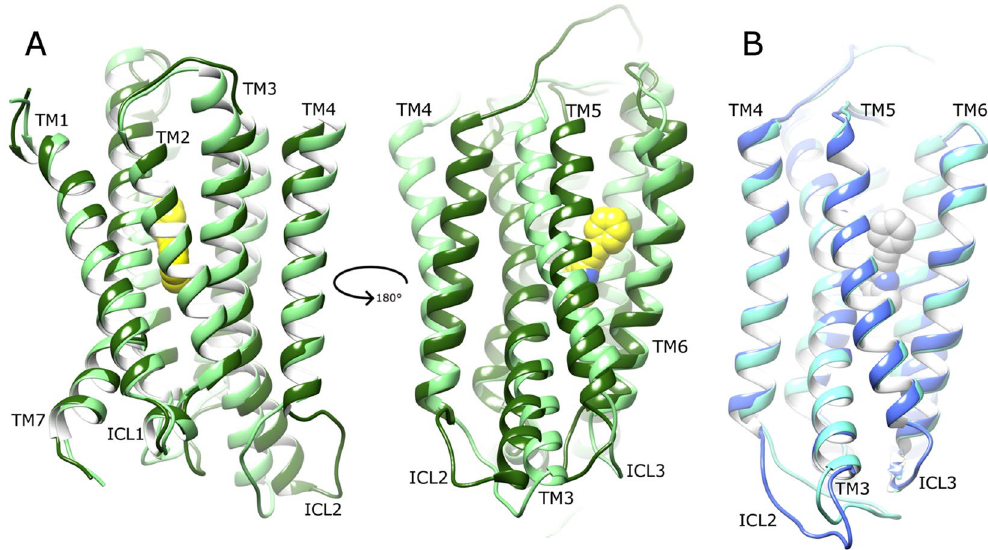
Figure 7. Comparison of average conformations of ( A ) mGlu4 with bound MPEP (dark green, yellow, respectively) and apo mGlu4 without MPEP (light green) and ( B ) mGlu5 with bound MPEP (blue, light grey, respectively) and apo mGlu5 without MPEP (cyan), obtained from 2.5–5 µ s of respective MD simulations. A 180° rotation around the membrane plane of mGlu4 allows differences to be noted from opposite angles. Receptors are viewed from side, within membrane, with extracellular-side, top, and intracellular-side, bottom. Relevant structural features are labelled, i.e. intracellular loops (ICLs) and transmembrane helices